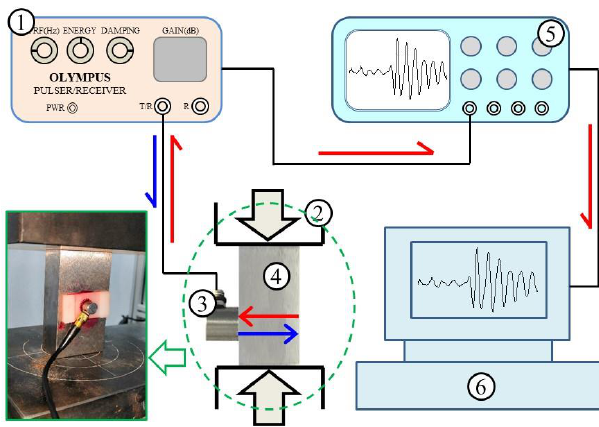
Figure 4. Measurement system: schematic diagram.